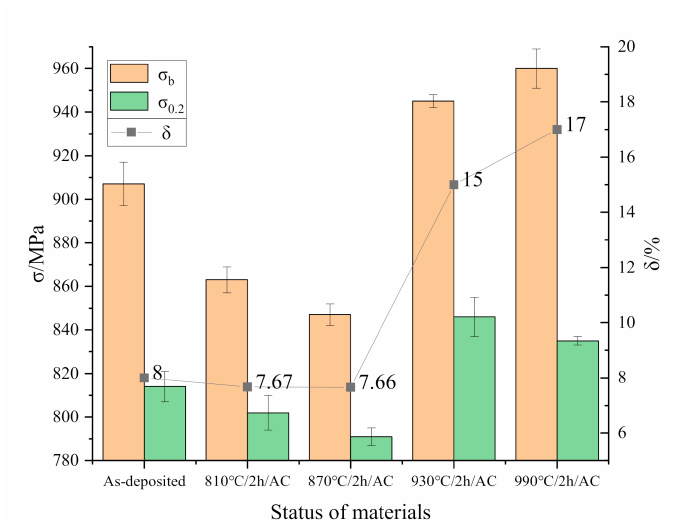
Figure 10. Room temperature tensile properties of Ti-6Al-4V (TC4) alloy by selective laser melting.